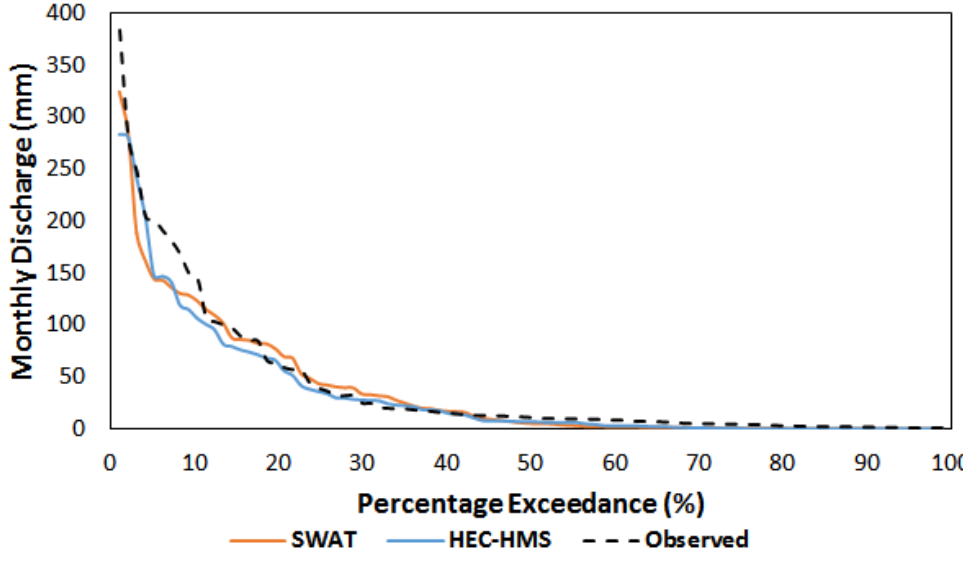
Figure 7. FDCs for monthly simulated streamflows by the HEC-HMS and SWAT models compared to the observed monthly streamflow within the period 2007–2014.